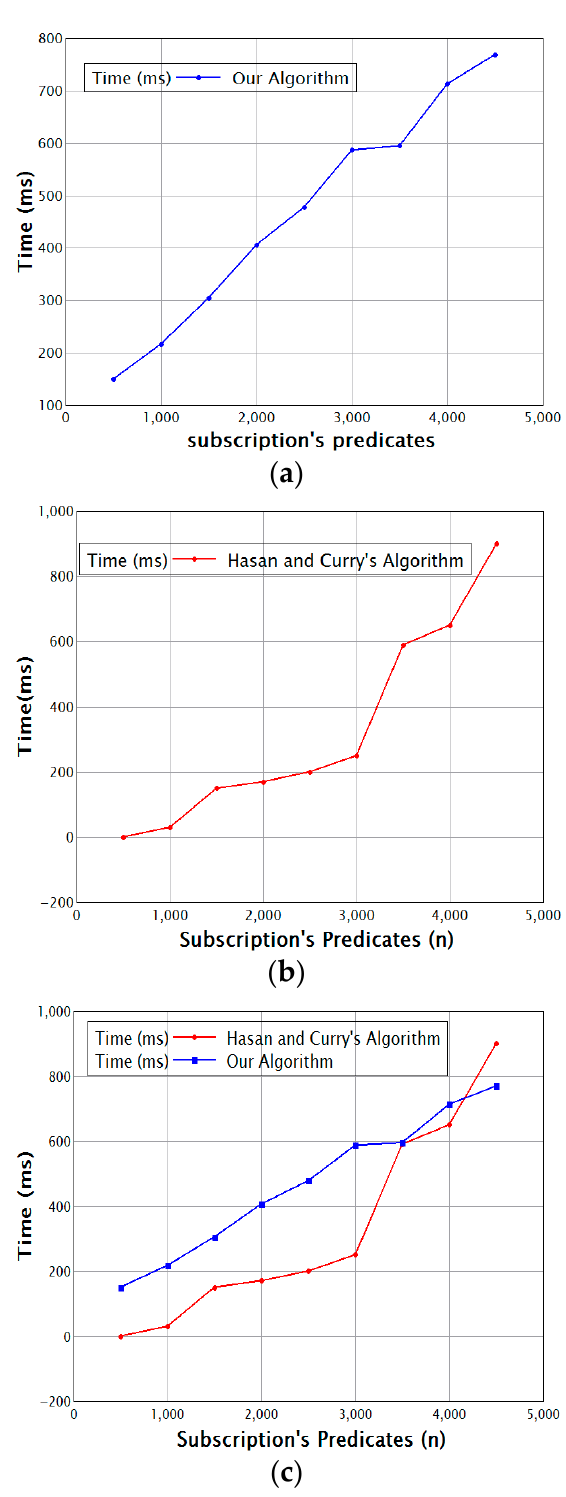
Figure 5. Subscription predicates vs. time ( a ) for our algorithm and ( b ) for the algorithm of Hasan and Curry; ( c ) Comparison of the two methods.